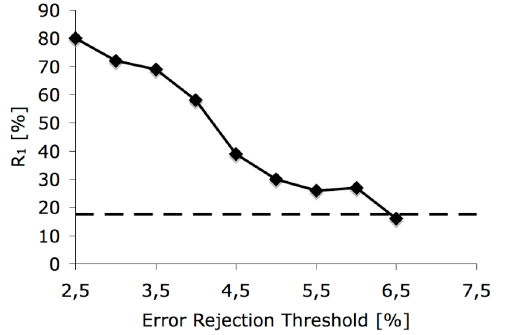
Figure 17 : Evolution with he ERT of the best- obtained R 1 for the problem of Fe-Cu 1nn . R 2 has immediately vanished during the GA optimization in all cases.